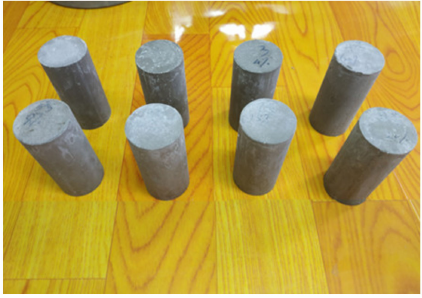
Figure 2. Silica fume cement stabilized soil samples after